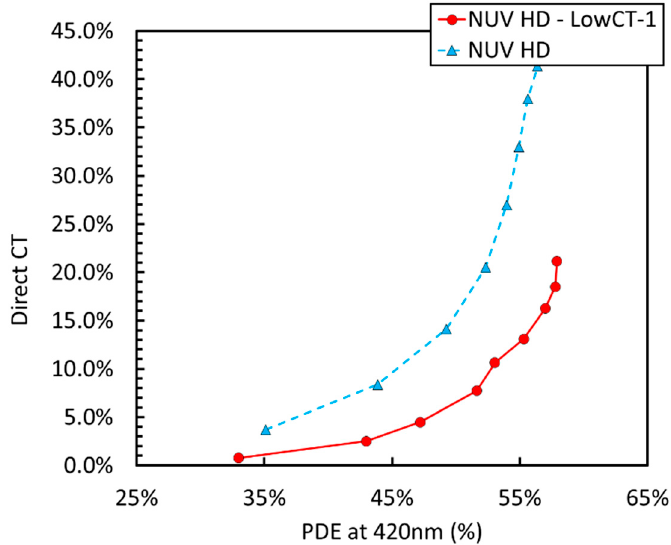
Figure 13. Probability of DiCT as a function of the PDE at 420 nm for standard NUV-HD and LowCT technologies.